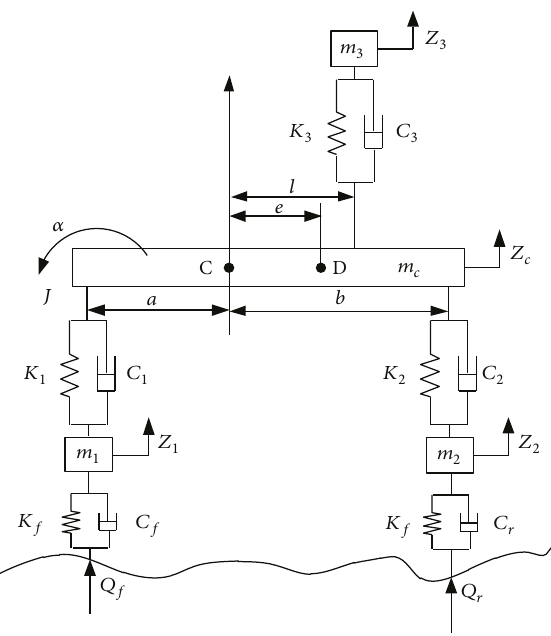
Figure 3: Vehicle vibration model with fi ve degrees of